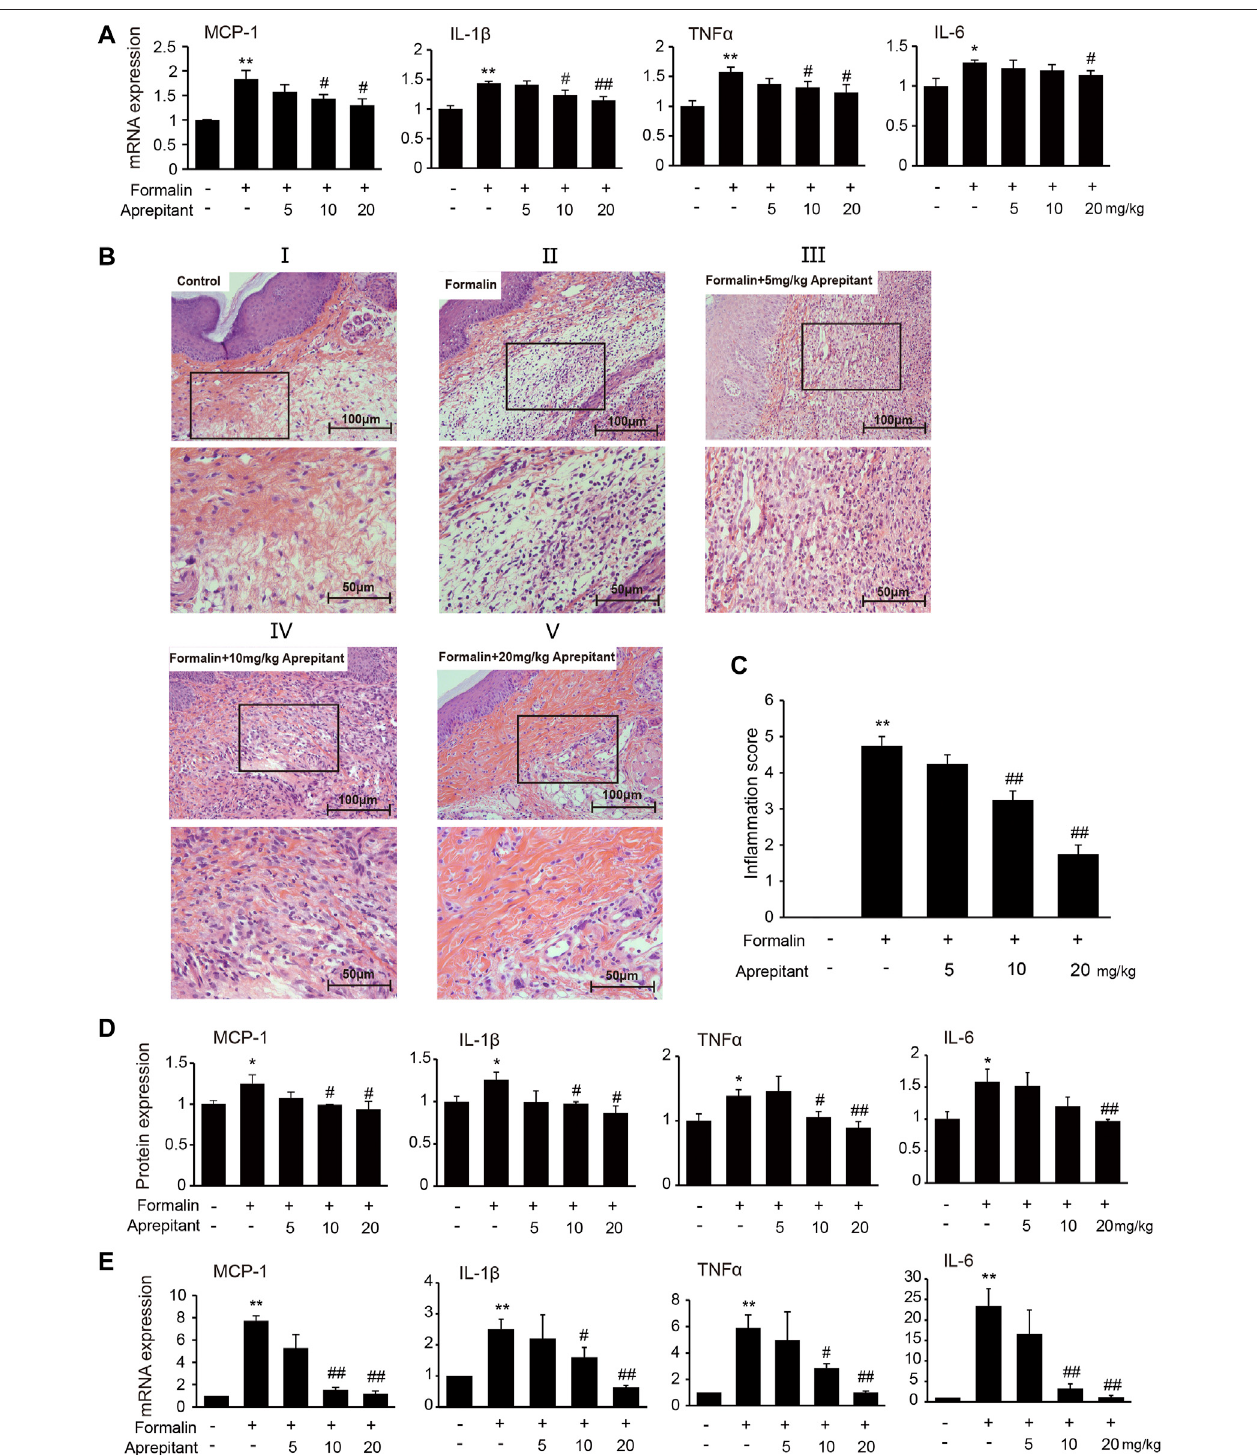
FIGURE 2 | Anti-in fl ammatory effects of aprepitant in mice with formalin-induced in fl ammatory pain. (A) mRNA expression of MCP-1, IL-1 β , TNF- α and IL-6 in the in fl amed paw after administration of aprepitant. (B, C) Hematoxylin eosin (HE) staining (B) and the scores (C) of paw tissues of mice. Each photo is representative of six specimens for each group. (D, E) The protein (D) and mRNA (E) levels of MCP-1, IL-1 β , TNF- α and IL-6 in the spinal cord of formalin treated mice after administration of aprepitant. Six samples were included in each of the groups ( n (cid:1) 6). Data are expressed as mean ± SEM. One-way ANOVA, * p < 0.05, ** p < 0.01 versus control, # p < 0.05, ## p < 0.01 versus formalin.